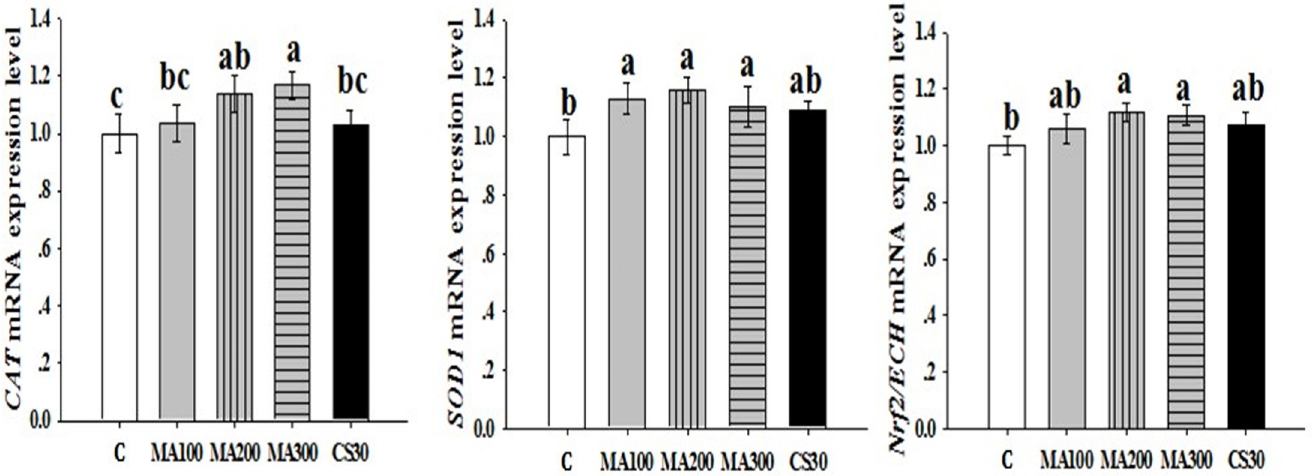
Fig 2. Effect of dietary magnolol at different levels on the mRNA expressions of hepatic antioxidant-related genes in 28 d Linwu ducklings. C: control, basal diet; MA100: basal diet + 100 mg magnolol additive/kg diet; MA200: basal diet + 200 mg magnolol additive/kg diet; MA300: basal diet + 300 mg magnolol additive/kg diet; CS30: basal diet + 30 mg antibiotic additive/kg